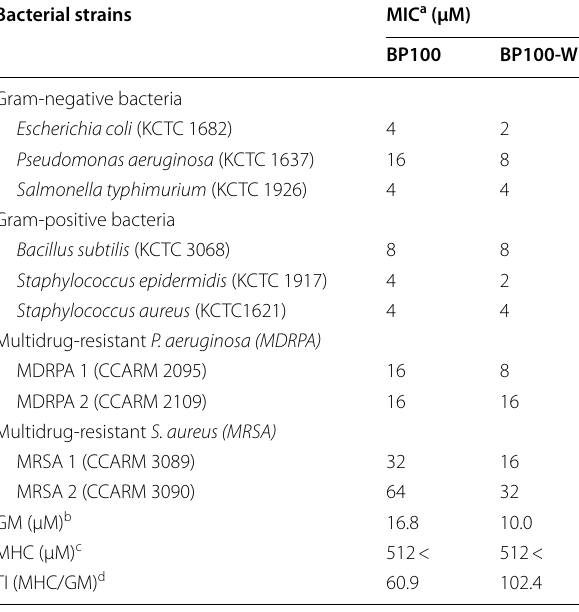
Table 2 Antimicrobial and hemolytic activities and therapeutic index (TI) of BP100 and BP100-W